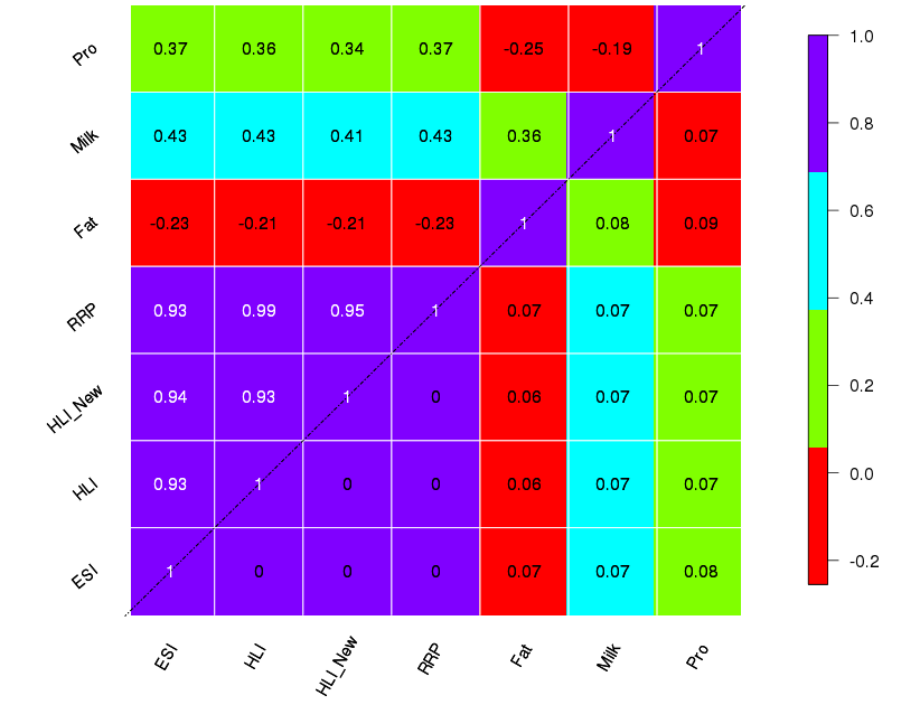
Figure 6. Correlation with bootstrapping between milk compounds and climatic indices in the summer (values under the diagonal are estimated confidence intervals from the inter-quartile